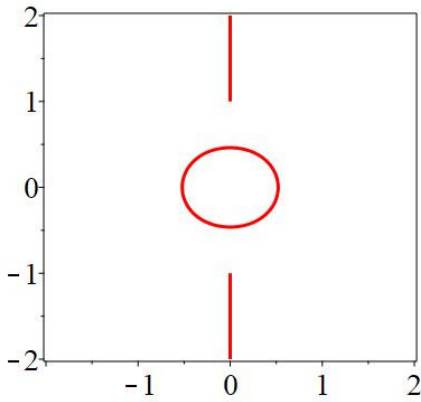
Figure 11 . Example path-integral geometry generating a BCFT state corresponding to a two-sided black hole system with dynamical energy